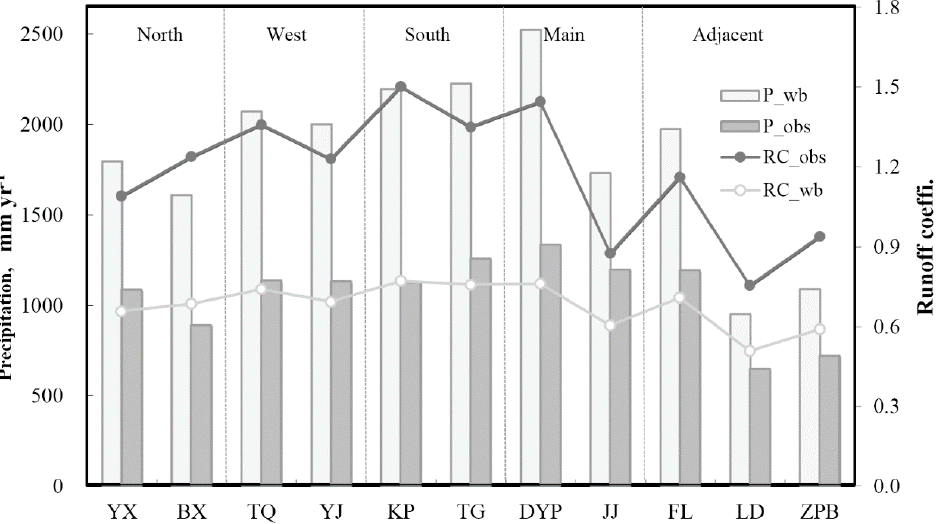
Figure 5. Spatial variations in annual basin-scale precipitation and runoff coefficient estimated respectively by water balance and weather sites in the QYJ sub-basins and adjacent basins. The hydrological gauges were used to represent corresponding basins.